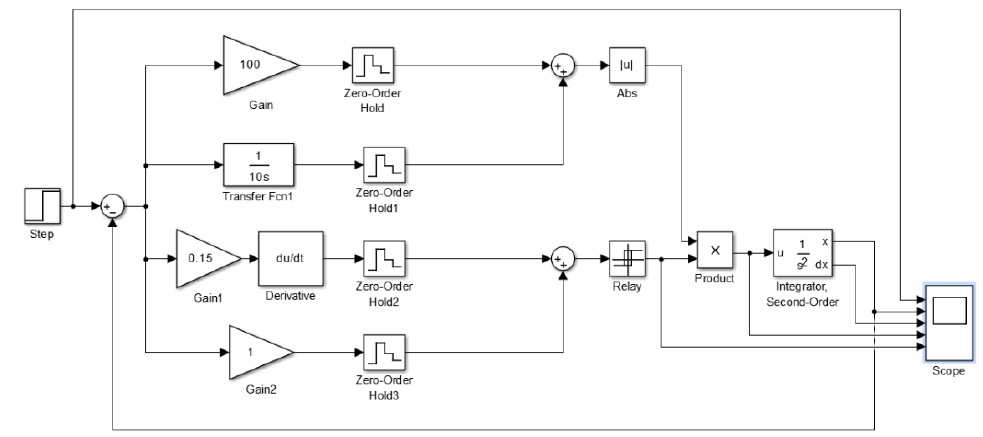
Figure 9. Block diagram of an VSS with sliding processes with separate sampling channels in the controller.